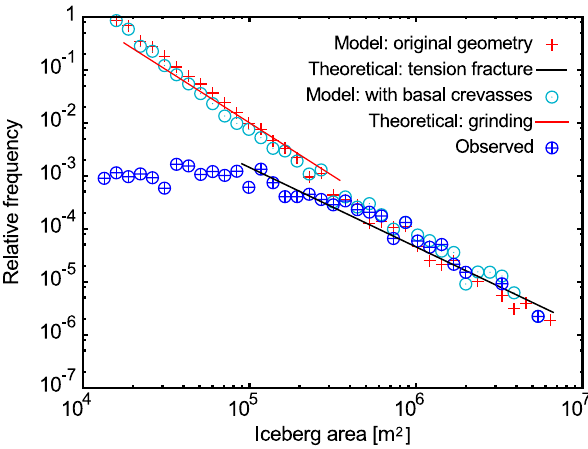
Figure 7. Evaluation of iceberg size distributions. Frequency dis- tribution of simulated and observed iceberg sizes. Dark blue cir- cles show observed iceberg sizes, red crosses show icebergs pro- duced by the original model geometry and pale blue circles show icebergs produced by the modified geometry with additional basal crevasses. Overlaid are theoretical distributions for brittle fragmen- tation (area − 3 / 2 , black line) and grinding (area − 2 , red